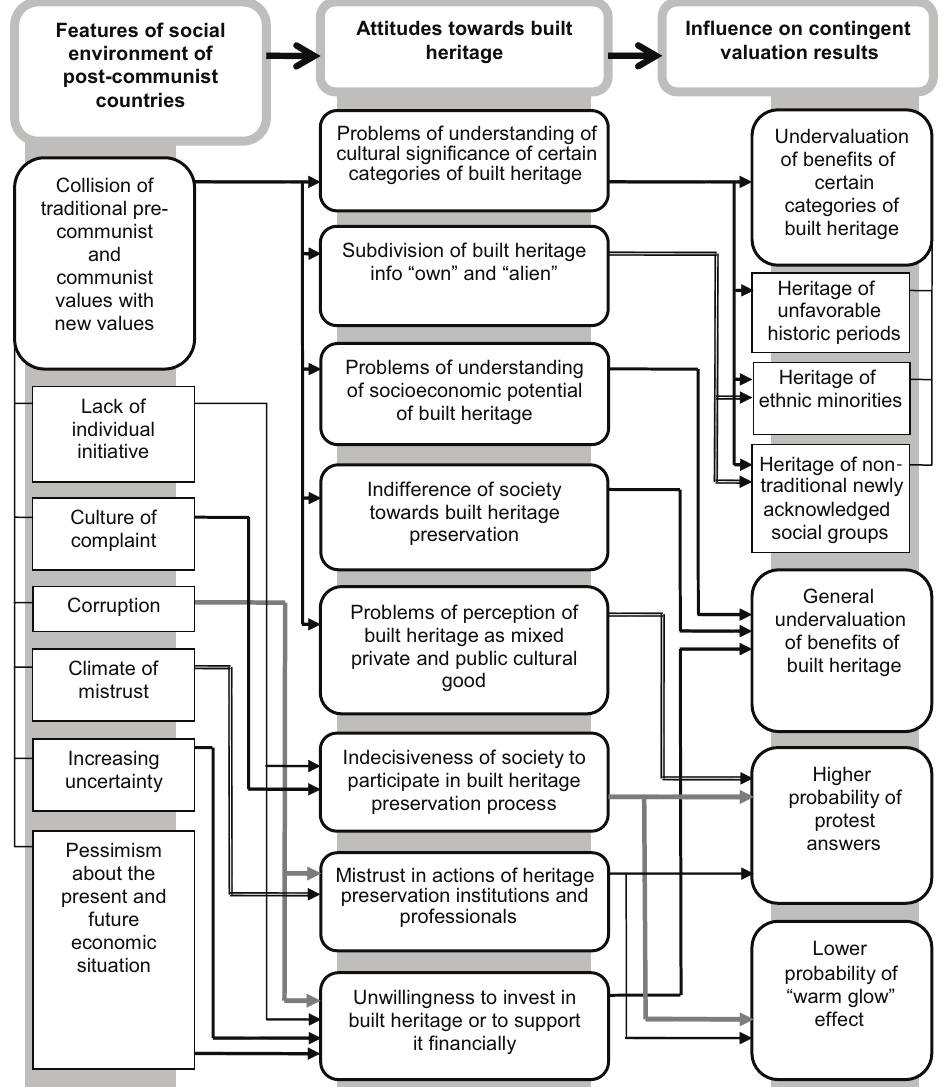
figure 2. The theoretical model of the influence of the social environment of the post-communist countries on the individual willingness to pay for the benefits of the built